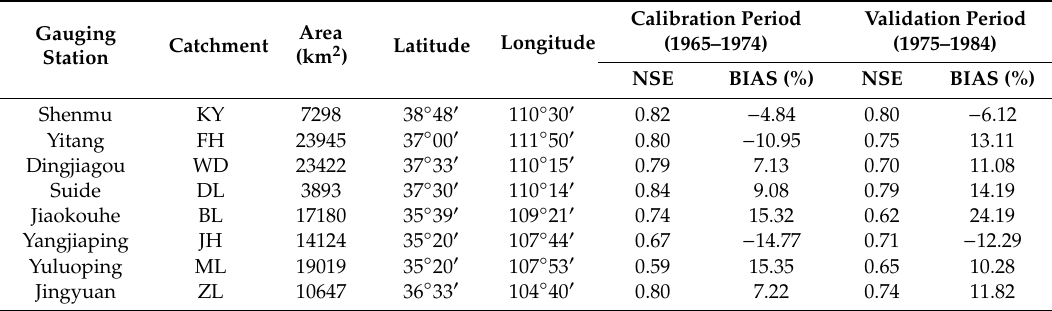
Table A1. Information of eight catchments used for calibrating and validating parameters and the performance of the VIC model for monthly runo ff simulation in each catchment.